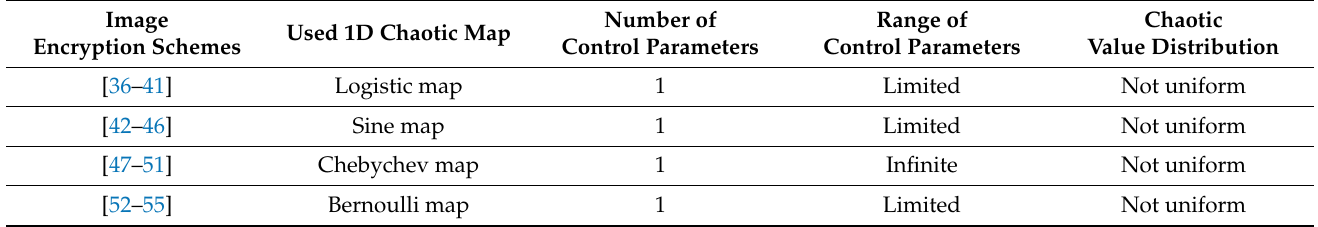
Table 1. Literature review of existing 1D chaotic maps applied to image encryption with characteris- tics related to the used chaotic